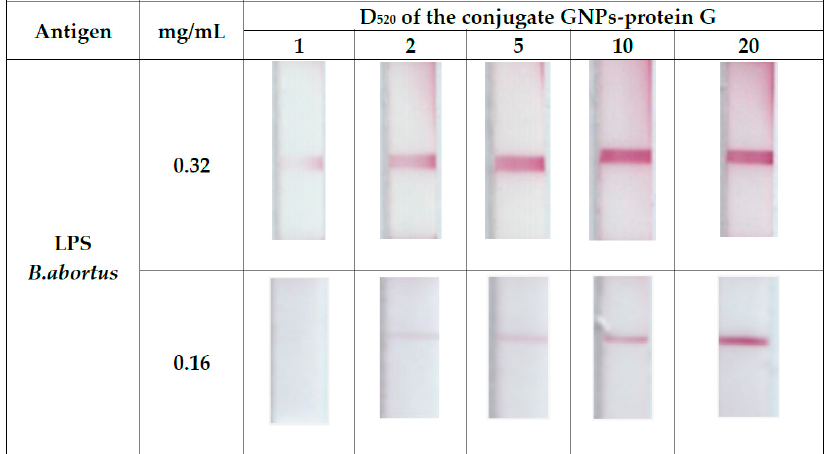
Figure 2. Testing a serum sample by gold nanoparticles (GNP)-based immunochromatographic system with varied D 520 of the GNP-(protein G) conjugate and varied antigen concentrations.